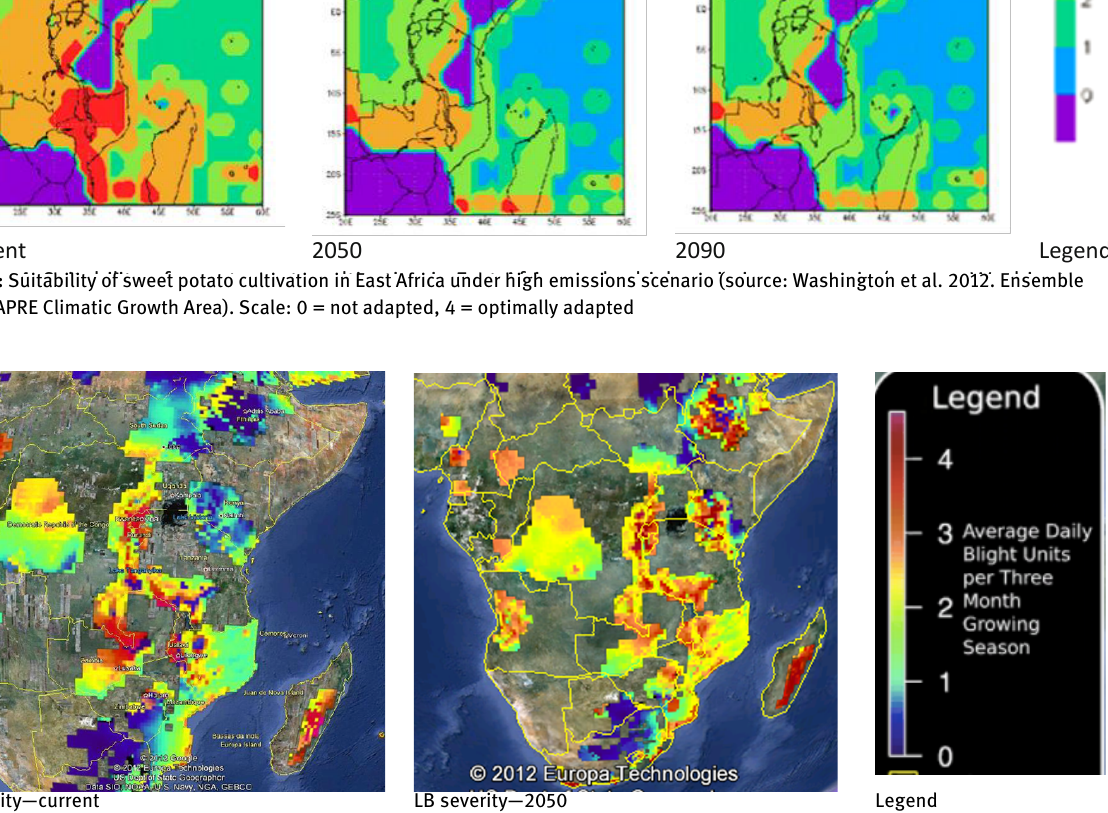
Figure 5: Predictions of potato late blight severity in sub-Saharan Africa using a metamodel (source: Sparks et al.